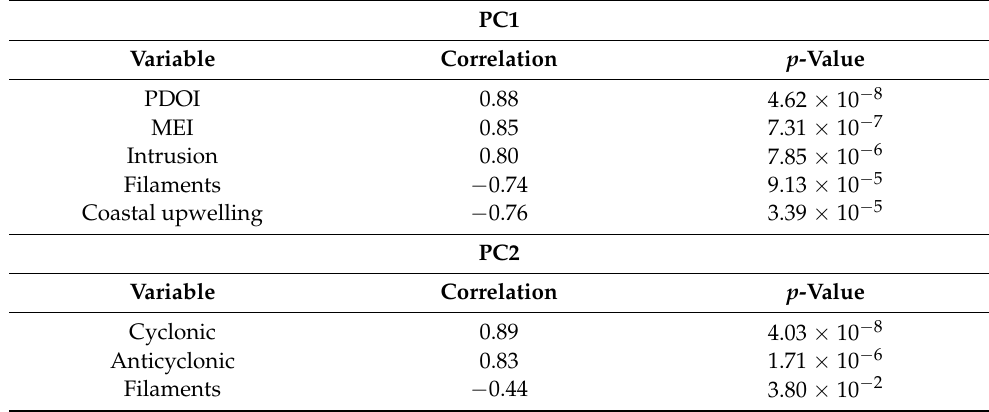
Table 3. Significantly associated variables within principal component 1 and 2 in the Southern Gulf of California.